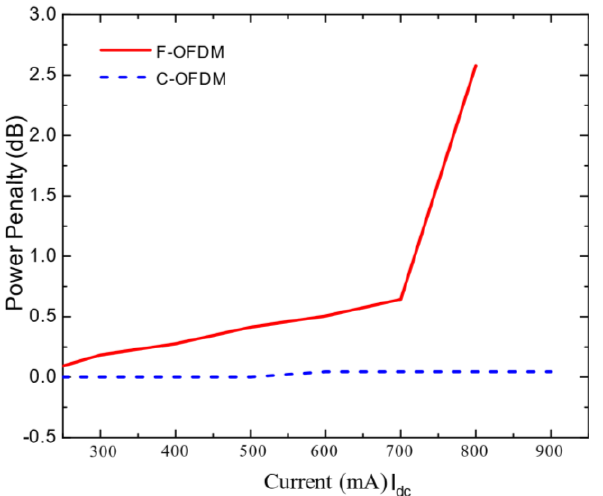
Figure 13. The net power penalty gains for C-OFDM over F-OFDM at 200 mA.